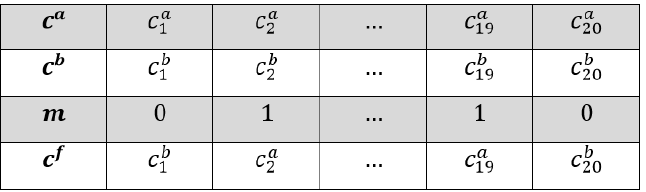
Figure 3. Operator crossing in the first part of the genome. Adapted from Ferreira, Ludermir and Aquino [15].